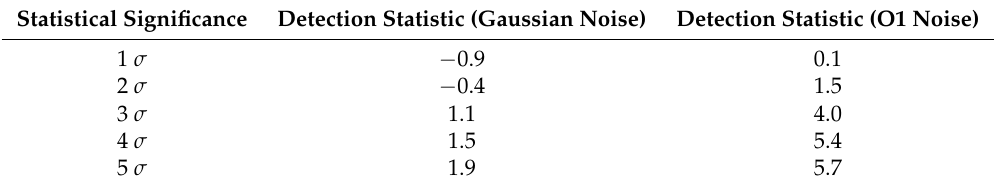
vs. its corresponding statistical significances shown for both Gaussian Table 16. Detection statistic ln B and O1 backgrounds [145].